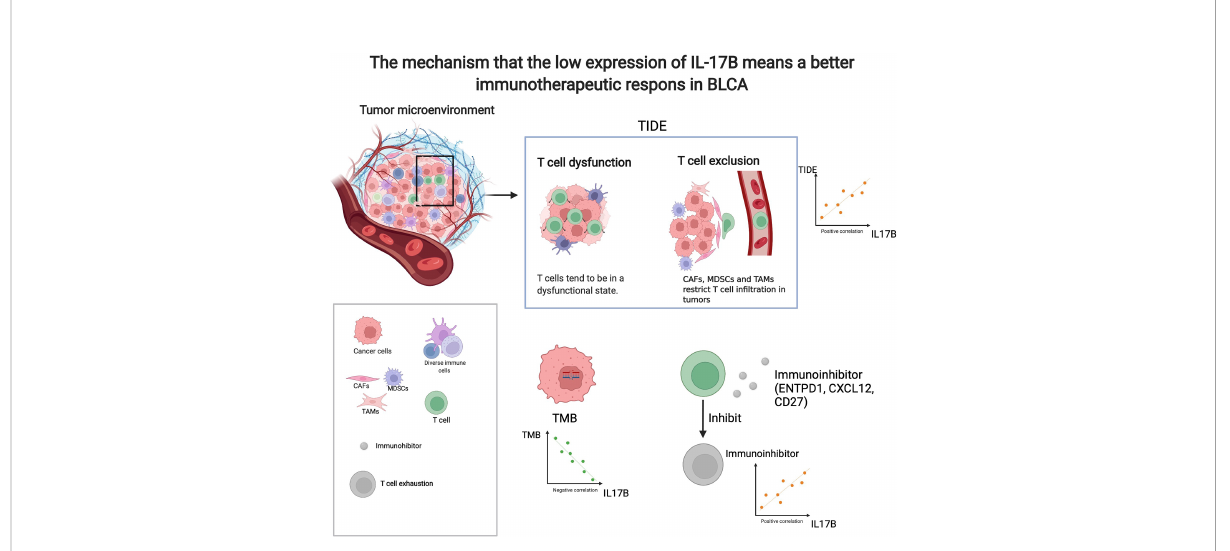
FIGURE 10 The mechanism that the low expression of IL-17B means a better immunotherapeutic response in BLCA. (created with biorender.com).